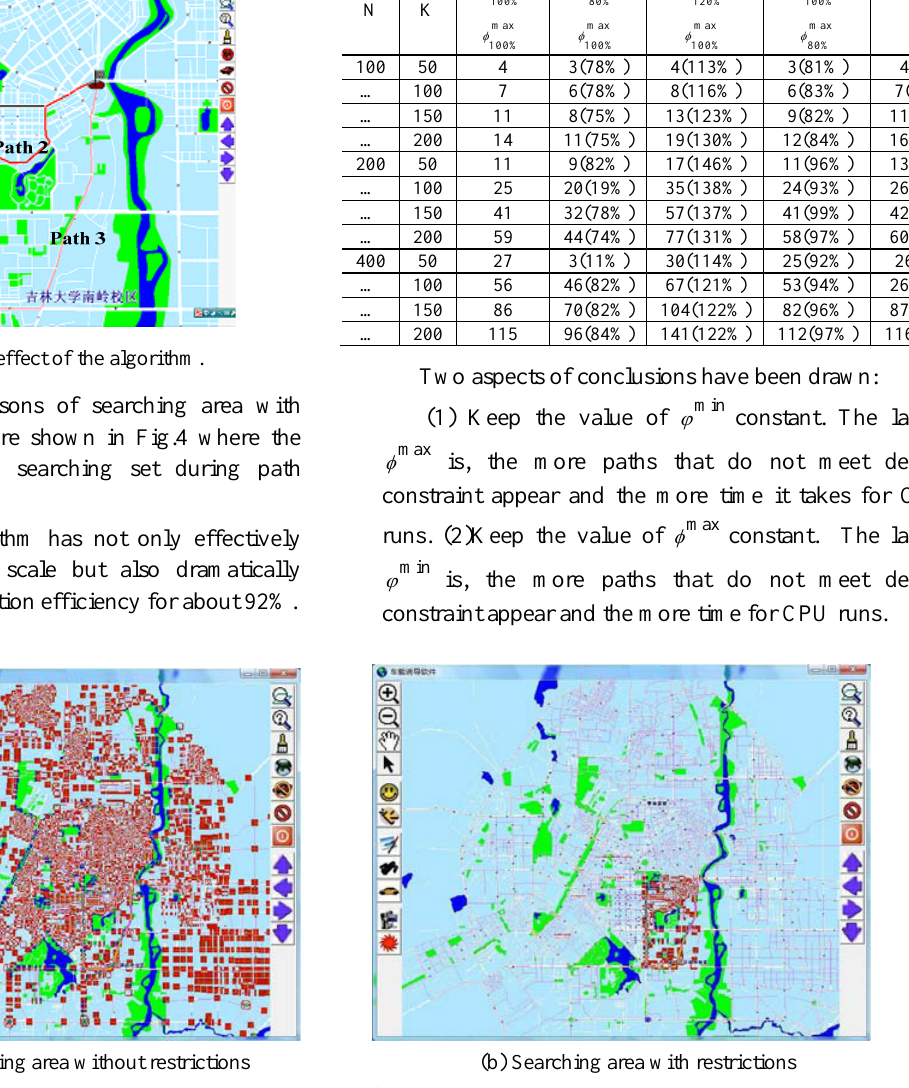
Fig. 4. Comparison of searching area